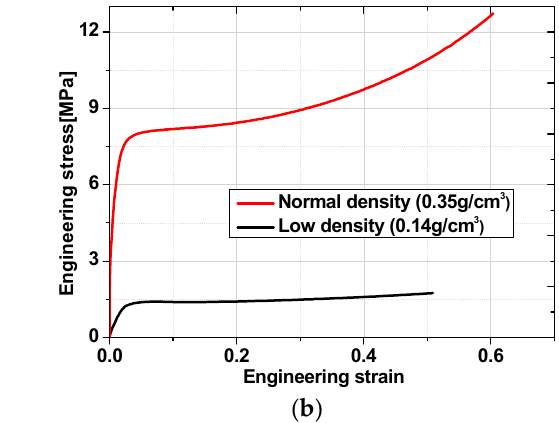
Figure 4. Experimental stress-strain curves in: ( a ) tensile test; ( b ) compressive test.